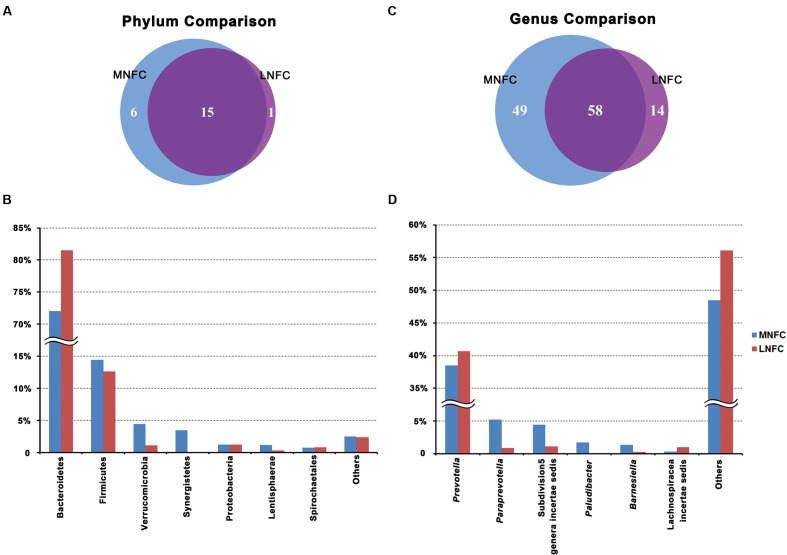
(A) Venn diagram showing the overlap of phyla between groups. (B) Phylum-level comparison of bacterial operational taxonomic units (OTUs)between the groups. (C) Venn diagram showing the overlap of genera between groups. (D) Genus-level comparison of bacterial OTUs in the BT group.